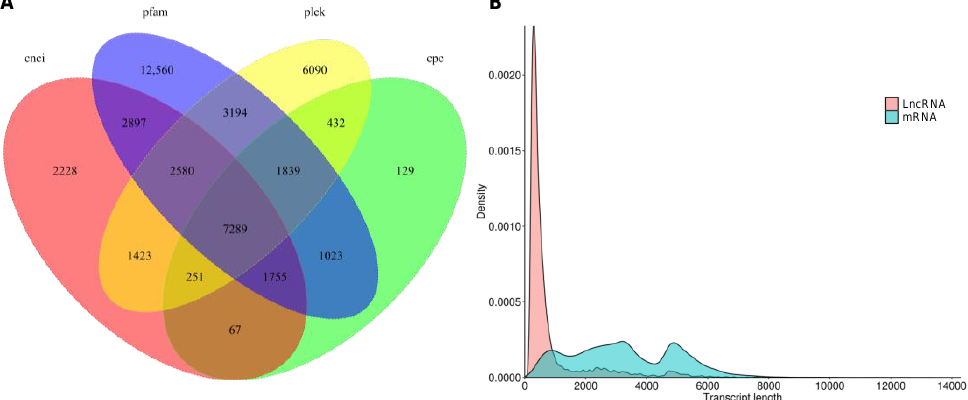
Figure 6. Identification of long non-coding RNAs (LncRNAs). ( A ). Venn diagram of LncRNAs predicted by PLEK, coding-non-coding index (CNCI), coding potential calculator (CPC) and protein family (Pfam) methods. ( B ). Density and length distributions of LncRNAs and mRNAs in purslane ( Portulaca oleracea ).